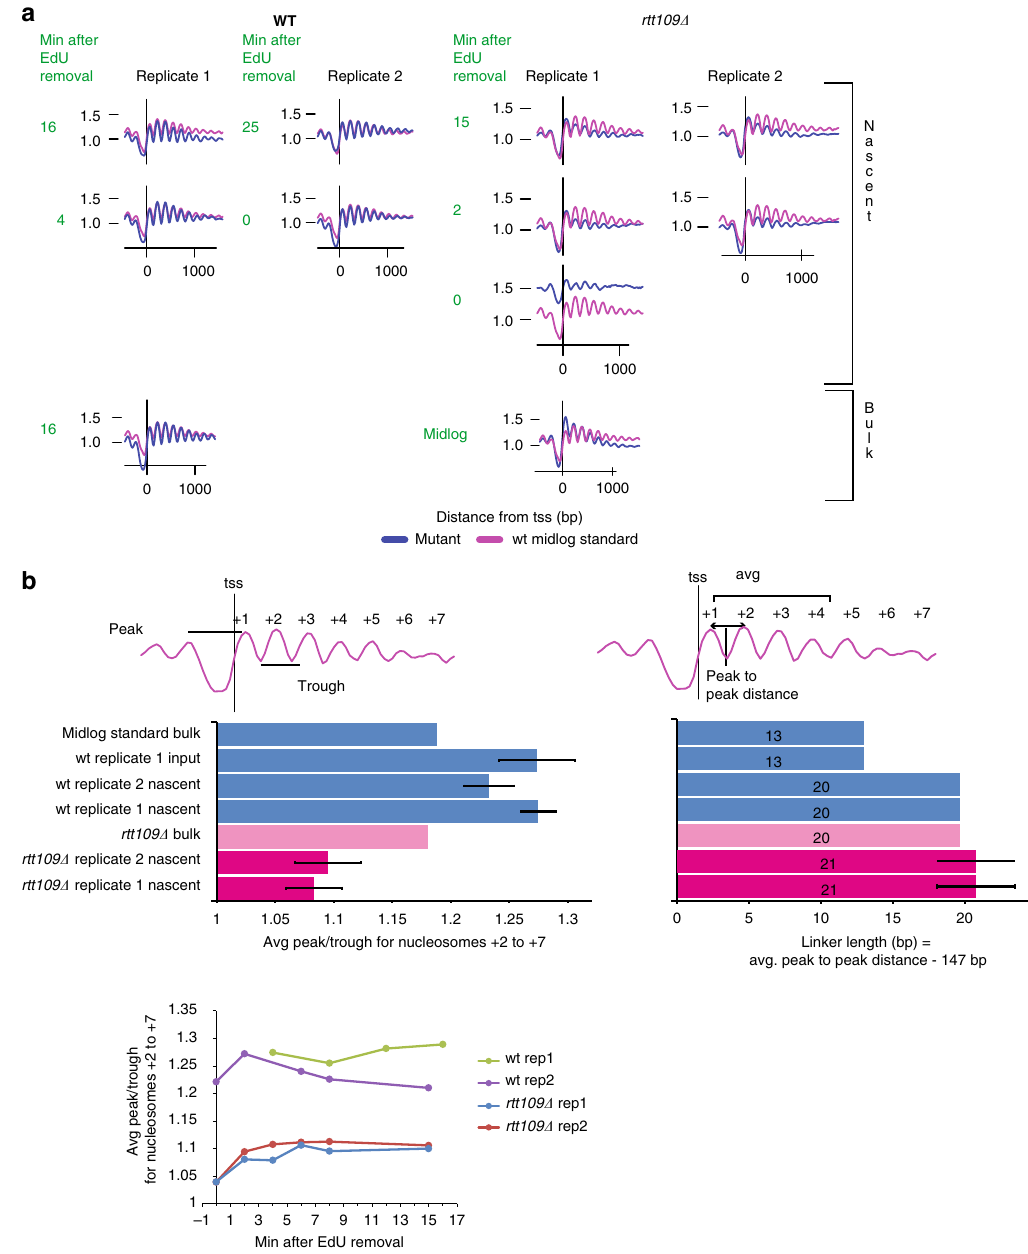
Fig. 6 Maturation of nucleosome positioning is delayed in rtt109 Δ cells. a Average TSS-aligned nucleosome pro fi les for all yeast genes for both WT (left panels) and rtt109 Δ cells (right panels) from nascent (top) and bulk chromatin (bottom). Wild-type pro fi les are taken from 43 . Pro fi les for the earliest and latest time point after 5 min EdU pulse and 5 min thymidine chase (green) are shown for nascent pro fi les. The last time point from the corresponding total chromatin input fraction is shown for wild-type replicate 1. Wild type midlog standard pro fi le (pink) is taken from ref. 65 . b Average peak/trough ratios (for nucleosomes + 2 to + 7) (left) and average linker length (values in the center of the bar) (between nucleosomes + 1 and + 2, + 2 and + 3, + 3 and + 4) (right). The error bars represent the standard deviation between time points in the EdU pulse-chase experiment. The plot on the bottom left shows the changes in the average peak/trough ratio (nucleosomes + 2 to + 7) after EdU removal for 2 biological replicates of wild type and rtt109